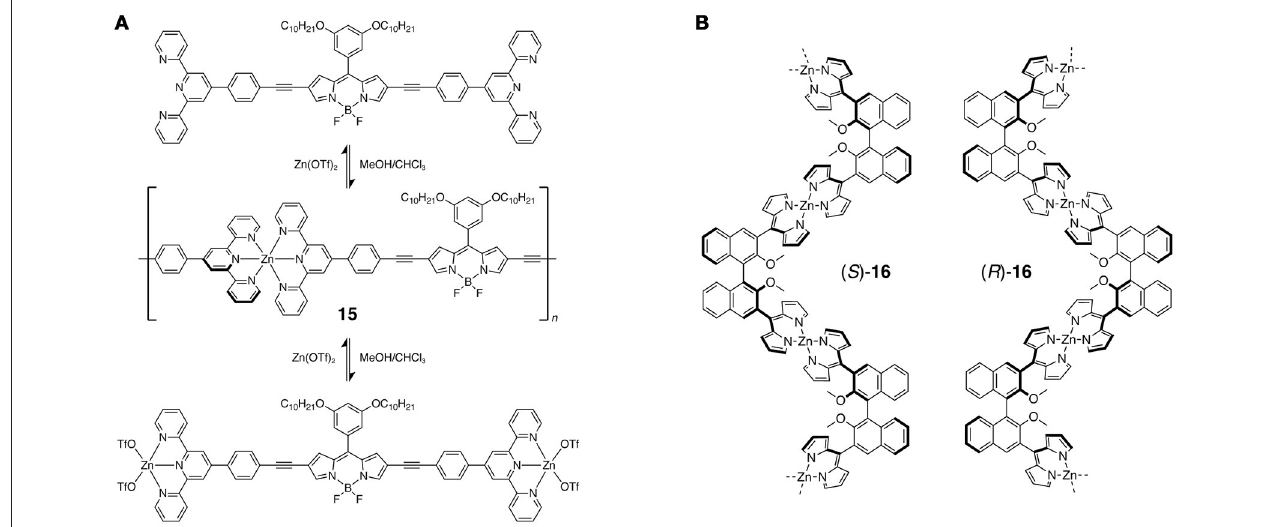
FIGURE 9 | (A) Dynamic equilibrium between a bis(terpyridyl)BODIPY ligand, 1D coordination polymer 15 , and a monomeric complex upon addition of Zn(OTf) 2 in MeOH/CHCl 3 mixture. (B) Chiroptical bis(dipyrrinato)zinc(II) one-dimensional coordination polymers ( S )- and ( R )- 16